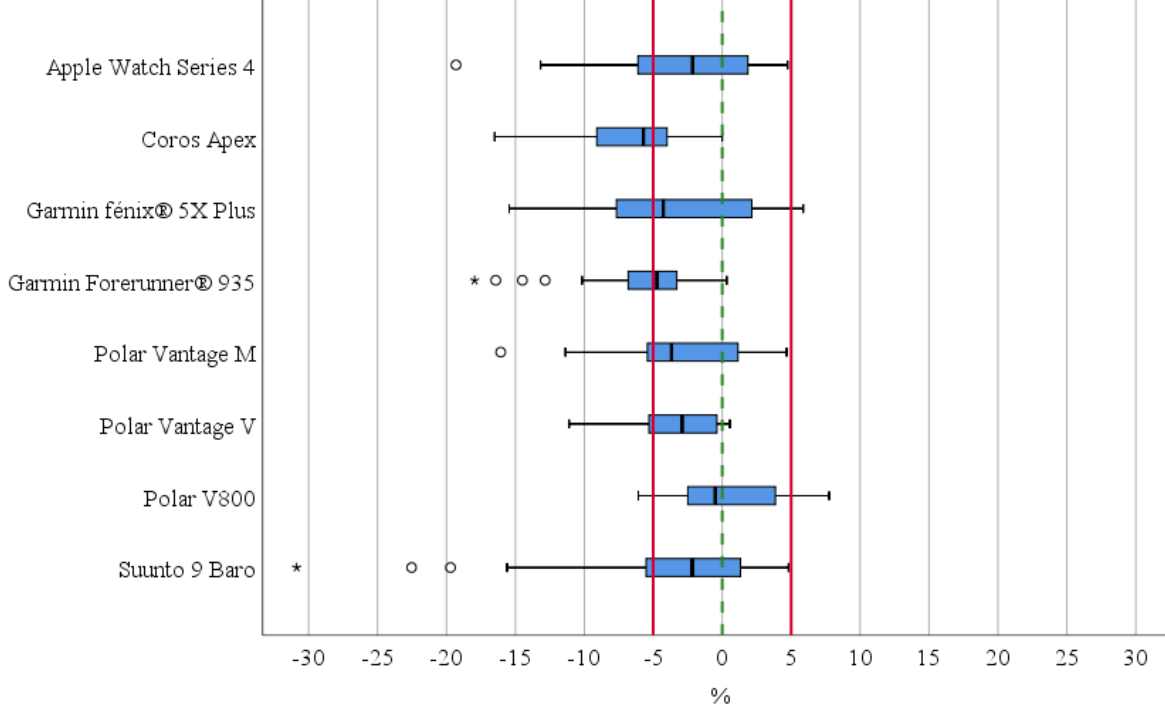
Figure 3. Relative deviation of the distances recorded by the 8 watches compared with the reference distance. The red lines indicate the proposed equivalence zone (±5% of the mean); the boxplots’ lower and upper boundaries indicate the 25% and 75% quantiles of the distance data, respectively, and the middle notch indicates the median data value. The whiskers include all data points that fall within the 1.5 interquartile range of the 25% and 75% quantile values. Circles and stars indicate distance data points that lie beyond the 1.5 and 3 interquartile ranges, respectively.